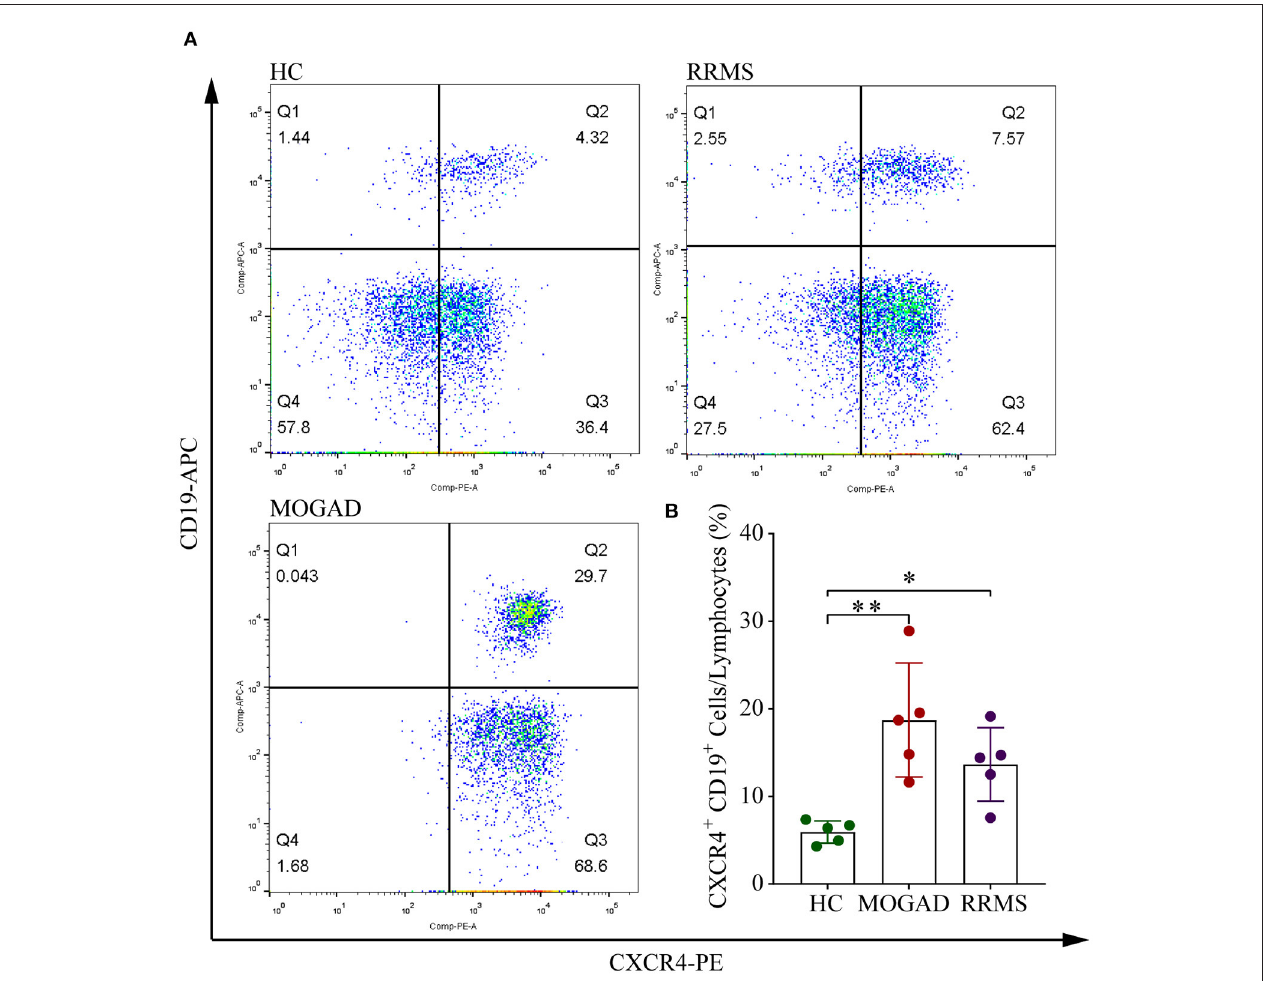
FIGURE 5 | Flow cytometry analysis of CD19 + CXCR4 + B cell subsets in HC, RRMS, and MOGAD. (A) Gating strategy of CD19 + CXCR4 + by flow cytometry. (B) Percentages of CD19 + CXCR4 + B cells of HC, MOGAD, and RRMS. HC, healthy controls; RRMS, relapsing-remitting multiple sclerosis; MOGAD, myelin oligodendrocyte glycoprotein (MOG) antibody-associated disease; PBMC, peripheral blood mononuclear cell. The data represent the mean ± SEM. * p < 0.05, ** p <